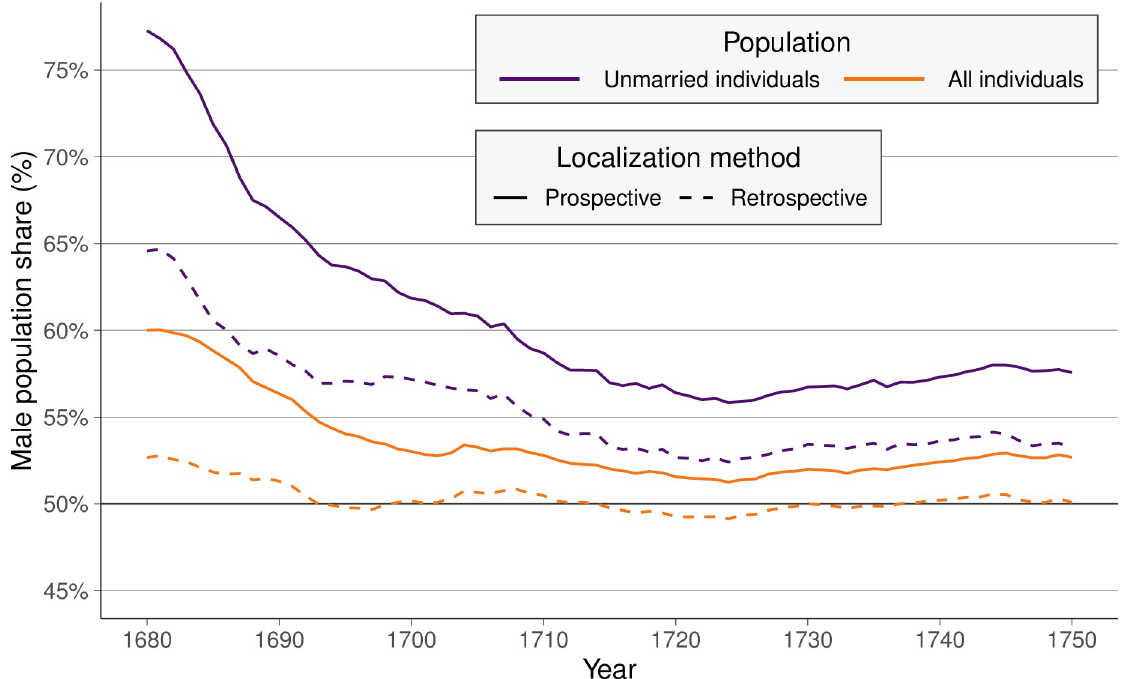
Fig 2. Different sex ratio measures for the population of the St. Lawrence valley. Individuals aged 14–50. PRDH data, 1680–1750.